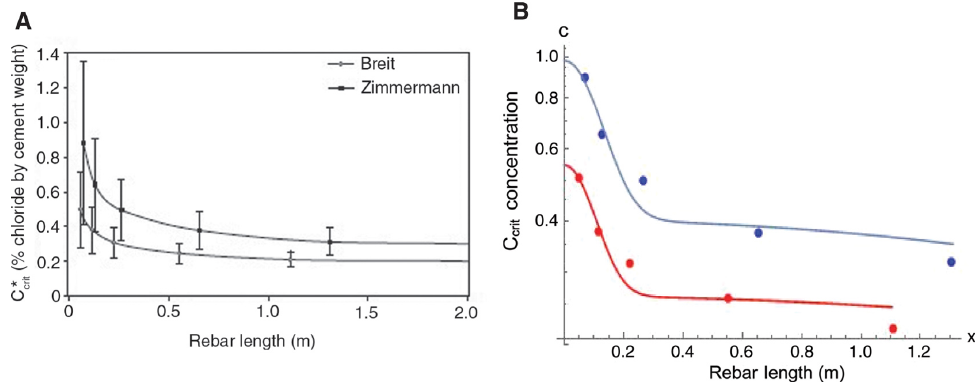
Figure 7: (A) Predicted mean value of C as a function of specimen size which is expressed in rebar length [24]. (B) crit Comparison between theoretical predictions and simulation results [24].